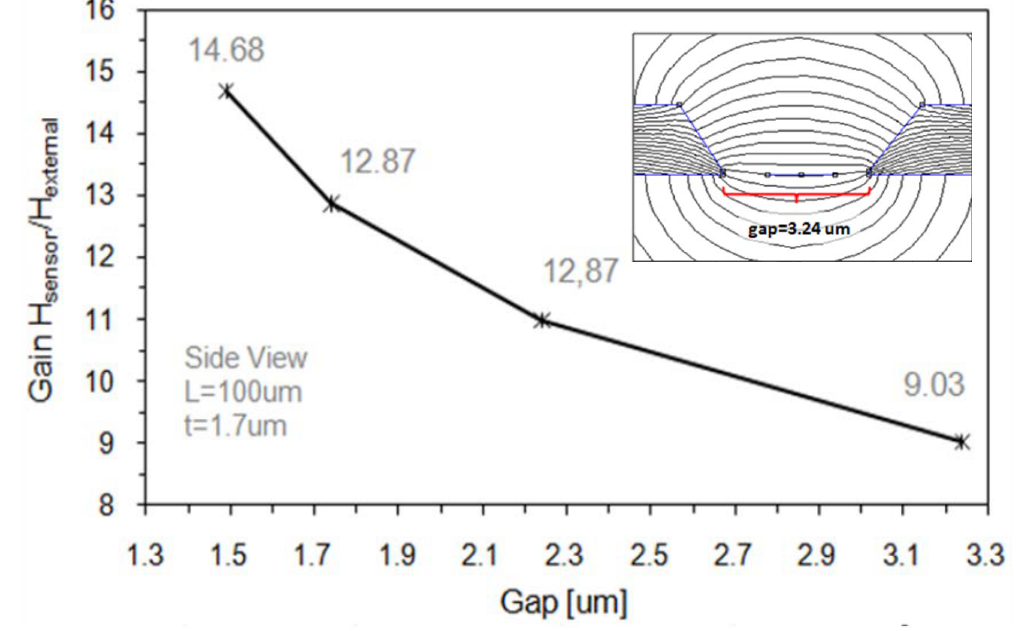
Figure 7. Simulated gain as a function of the gap between